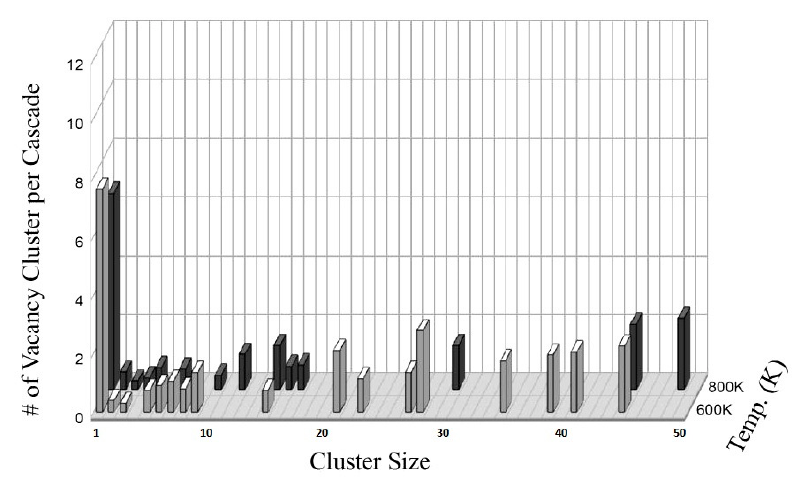
Figure 7. Vacancy cluster distribution at 600 K (white column) and 800 K (gray column).